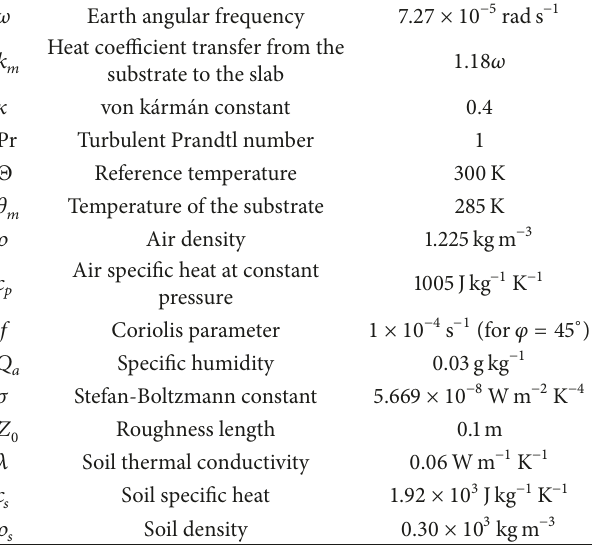
Table 1: List of constants used in the